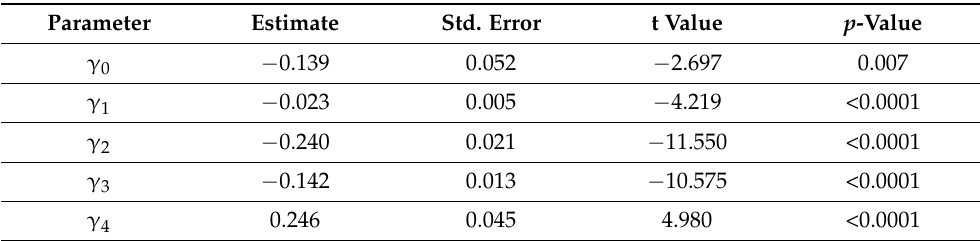
Table A3. Summary statistics of the linear model for detailed measurements of hardness, with